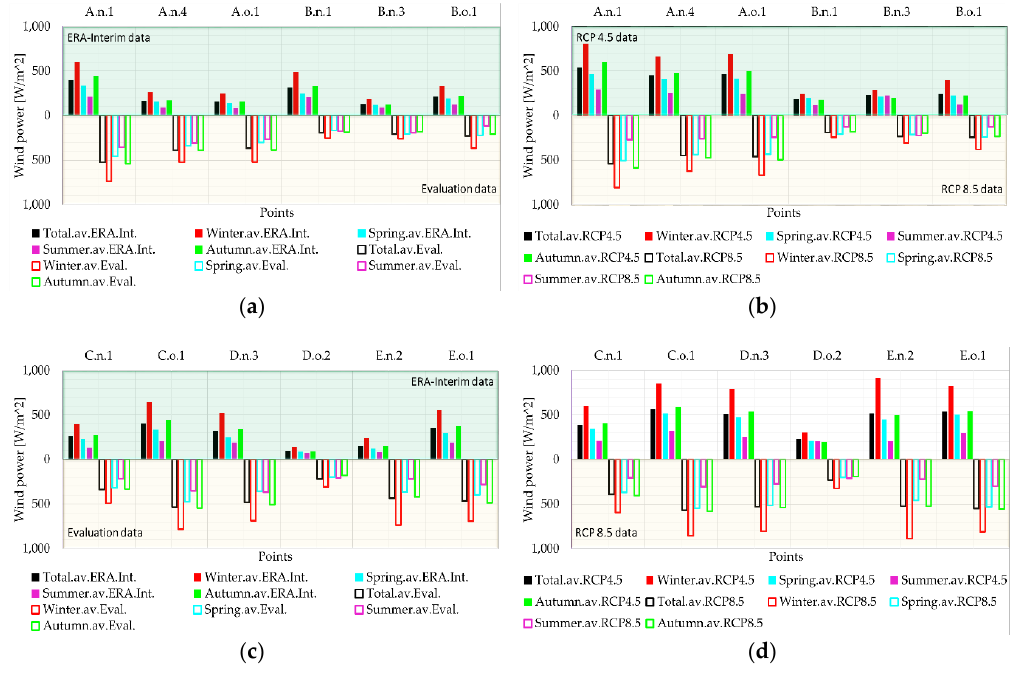
Figure 11. Seasonal wind power averages at 100 m height compared with the total time averages for 12 points considered the most representative. ERA.Int and Eval data, time interval 1981–2010; RCP4.5 and RCP8.5 data, time interval 2021–2050. Points A.n.1, A.n.4, A.o.1, B.n.1, B.n.3 and B.o.1: ( a ) ERA.Int and Eval data, ( b ) RCP4.5 and RCP8.5 data; Points C.n.1, C.o.1, D.n.3, D.o.2, E.n.2 and E.o.1: ( c ) ERA.Int and Eval data, ( d ) RCP4.5 and RCP8.5 data.